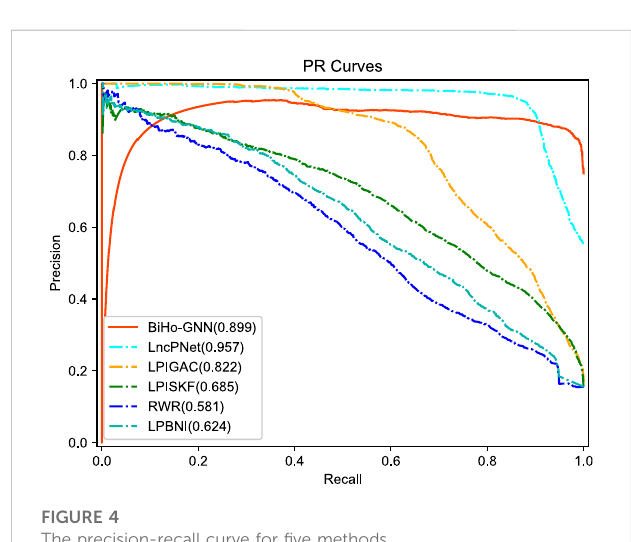
FIGURE 4 The precision-recall curve for fi ve